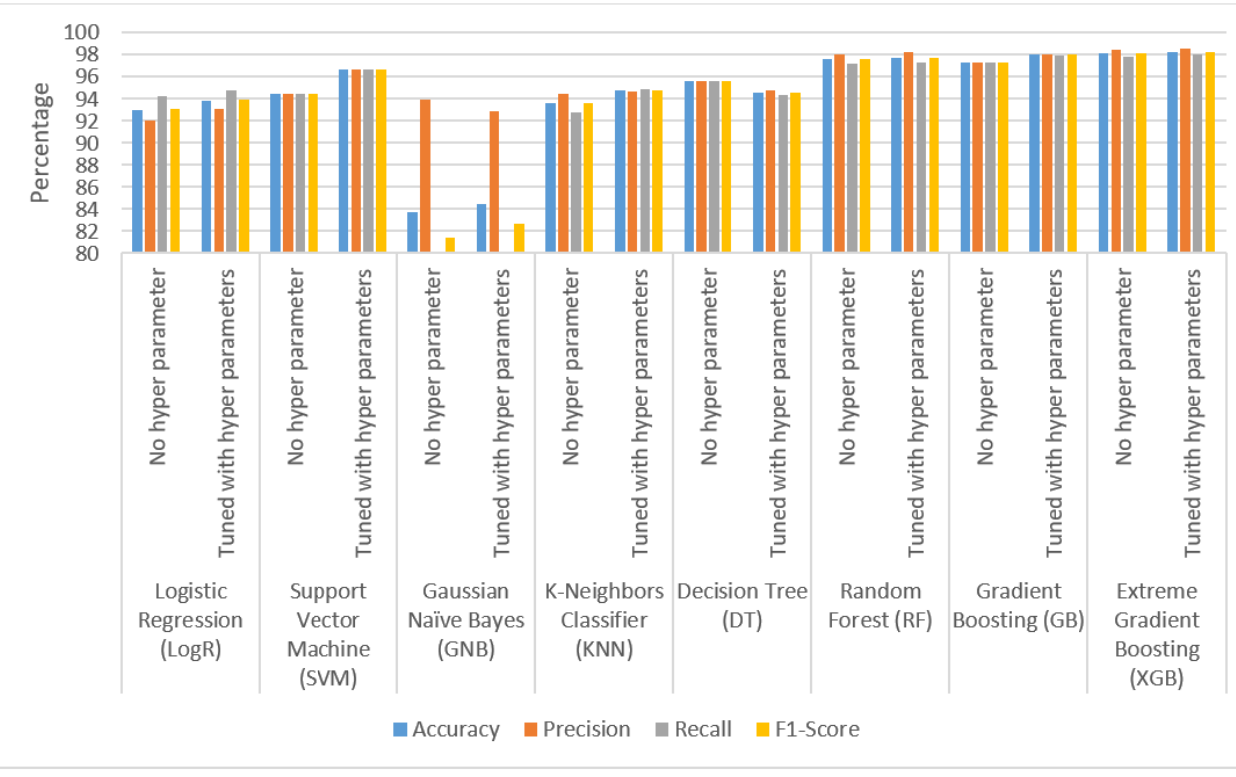
Figure 5. Performance comparison of hyper-parameter tuned and untuned model (Dataset-2).